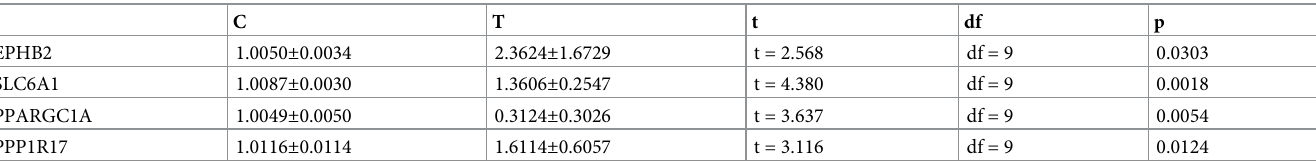
Table 4. qPCR results.